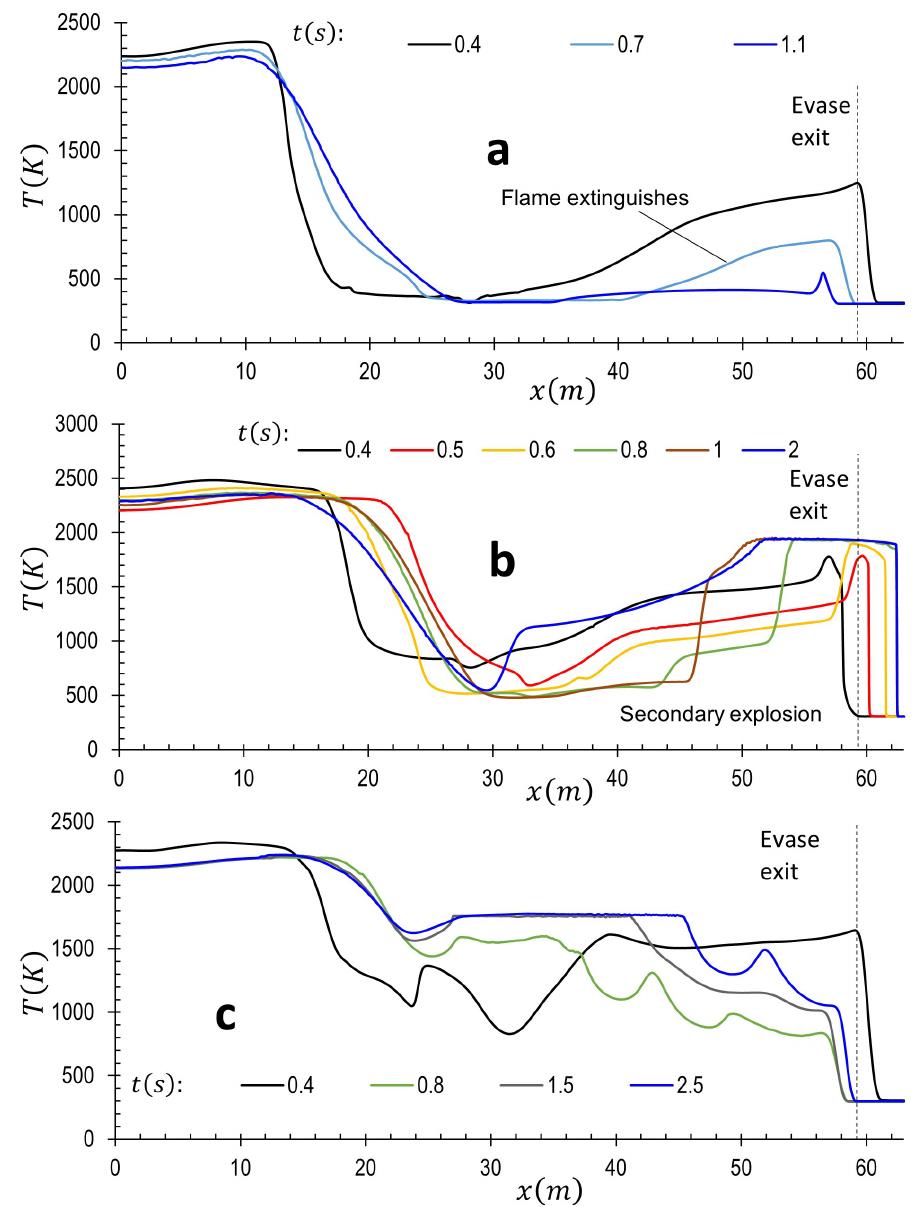
Figure 8. Time series of temperature profiles after the generated flame in the capture duct reaches the evasé for different methane concentrations in the RTO: ( a ) 5%; ( b ) 7.5% and ( c )